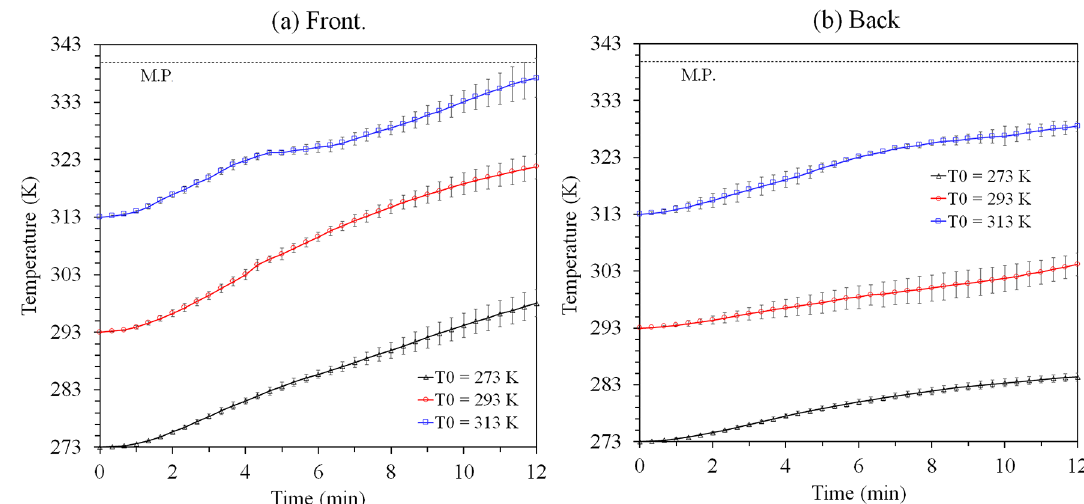
Figure 3. Temperature simulation on the surface at the front (a) and back (b) positions, in relationship to the gas flow. The dot line represents the melting temperature of the sample.